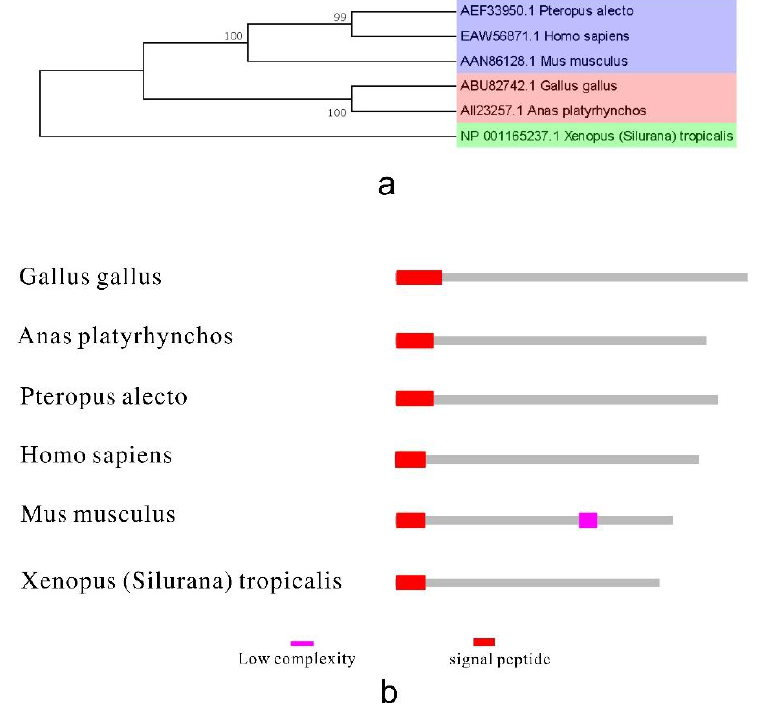
Figure 3. The phylogenetic tree and the protein structure of bird type III IFN. ( a ) The phylogenetic tree of type III IFN. It was built by MEGA5 program with 1000 bootstrap replicates and based on the neighbor-joining method. Blue, orange, green in the picture represent mammals, birds, reptiles and amphibians, respectively; and ( b ) The structure of bird type III IFN. Reference sequences: Gallus gallus [GenBank: ABU82742.1], Anas platyrhynchos [GenBank: AII23257.1], Pteropus alecto [GenBank: AEF33950.1], Homo sapiens [GenBank: EAW56871.1], Mus musculus [GenBank: AAN86128.1], Xenopus (Silurana) tropicalis [GenBank: